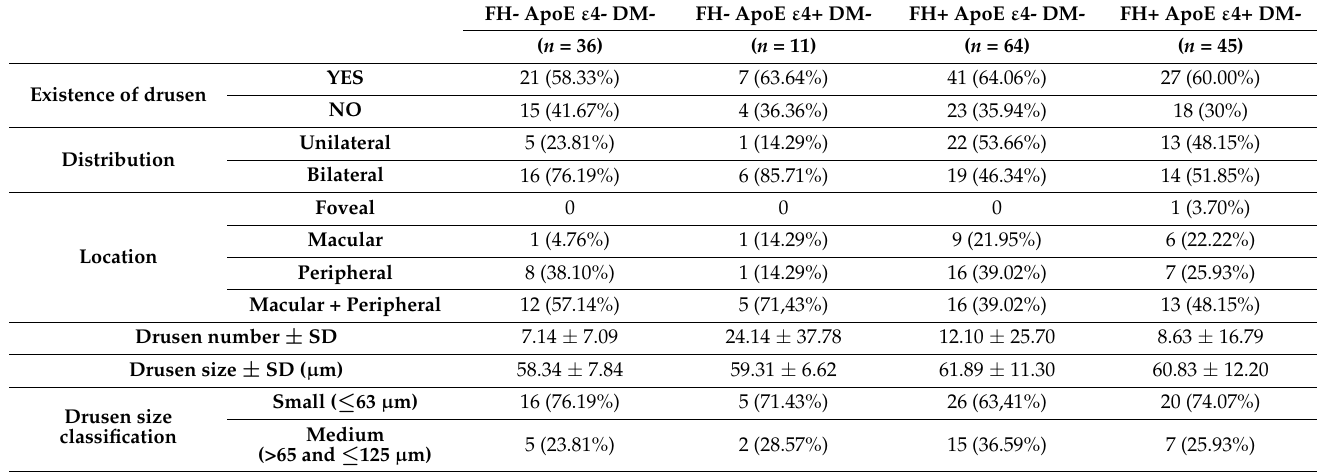
Table 8. Characterization of drusen by family history, ApoE genotype, and diabetes